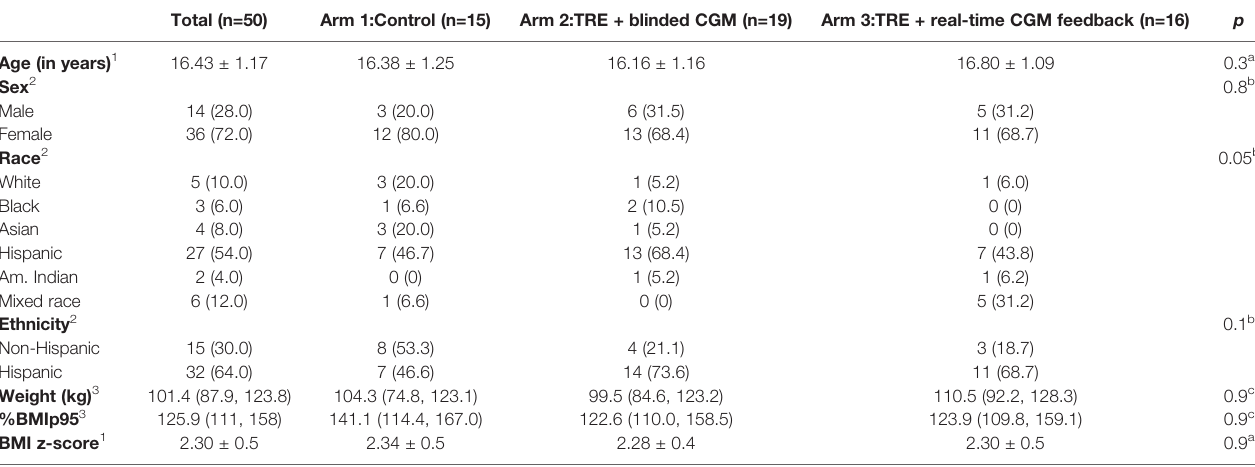
TABLE 1 | Demographic characteristics and baseline